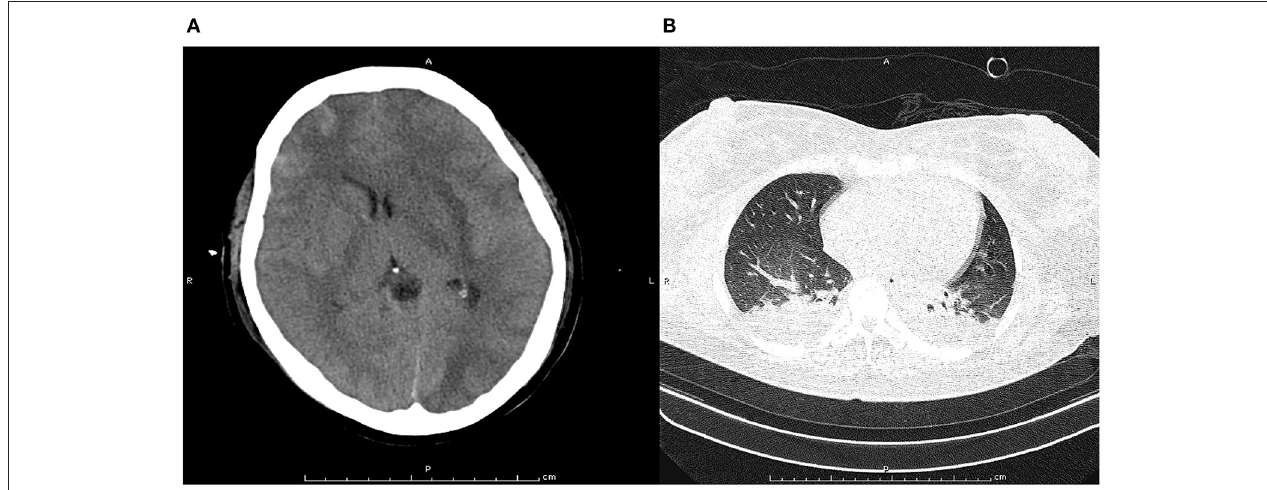
FIGURE 1 | Pre-treatment computed tomography scan at cranial (A) and chest (B) . The pre-treatment computed tomography scan at cranial indicated obvious cerebral tissue edema, ventricle compression, and subarachnoid hemorrhage. The pre-treatment computed tomography scan at chest found bilateral infection with pleural effusion in